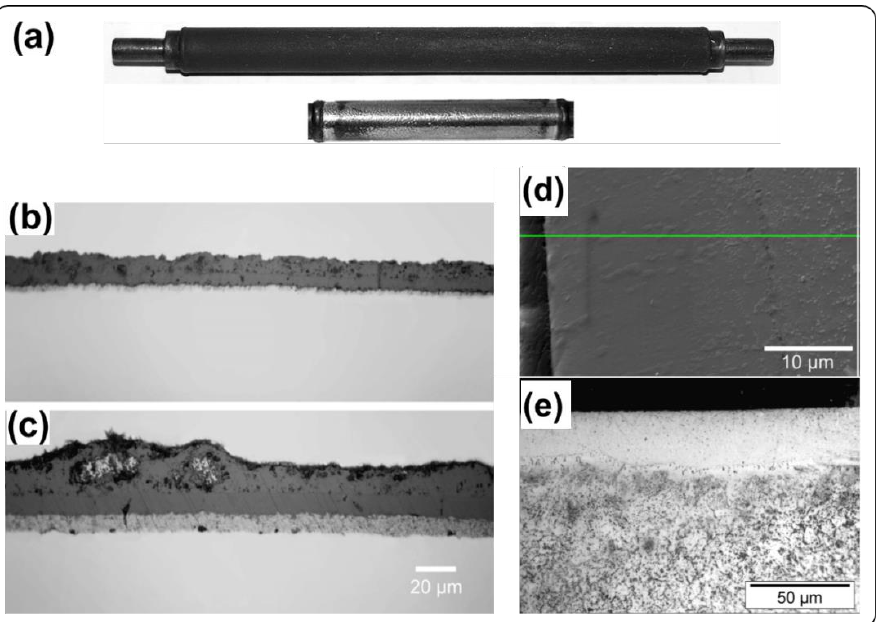
Figure 5. Physical photo of T91 cladding tubes without (dark) and with (shiny) FeCrAl coatings after corrosion test in LBE at 550 °C ( a ). T91 without coating after corrosion in LBE at 480 °C ( b ) and 550 °C ( c ). SEM photograph of T91 without FeCrAl coating after corrosion in LBE ( d , e ) [69]. Figure 5 is reprinted with permission from ref [69]. Copyright 2008 Elsevier.